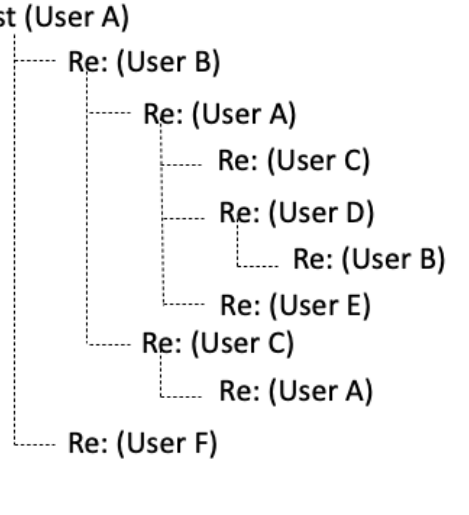
Figure 1. Illustration of a hypothetical user discussion